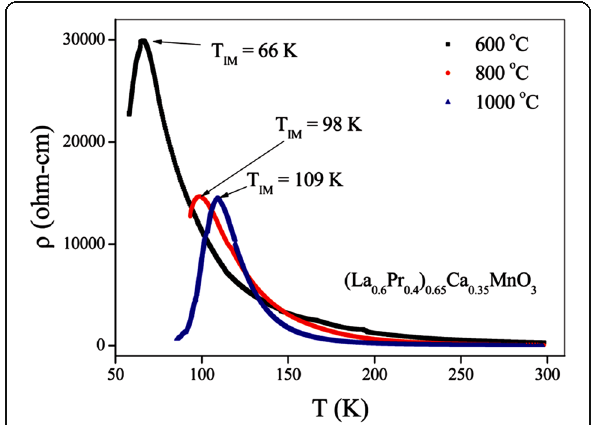
Fig. 23 Variation of resistivity with the temperature for the (La0.6Pr0.4)0.65Ca0.35MnO3 nanoparticles sintered at 600 °C, 800 °C, and 1000 °C, respectively. Reproduced with permission of